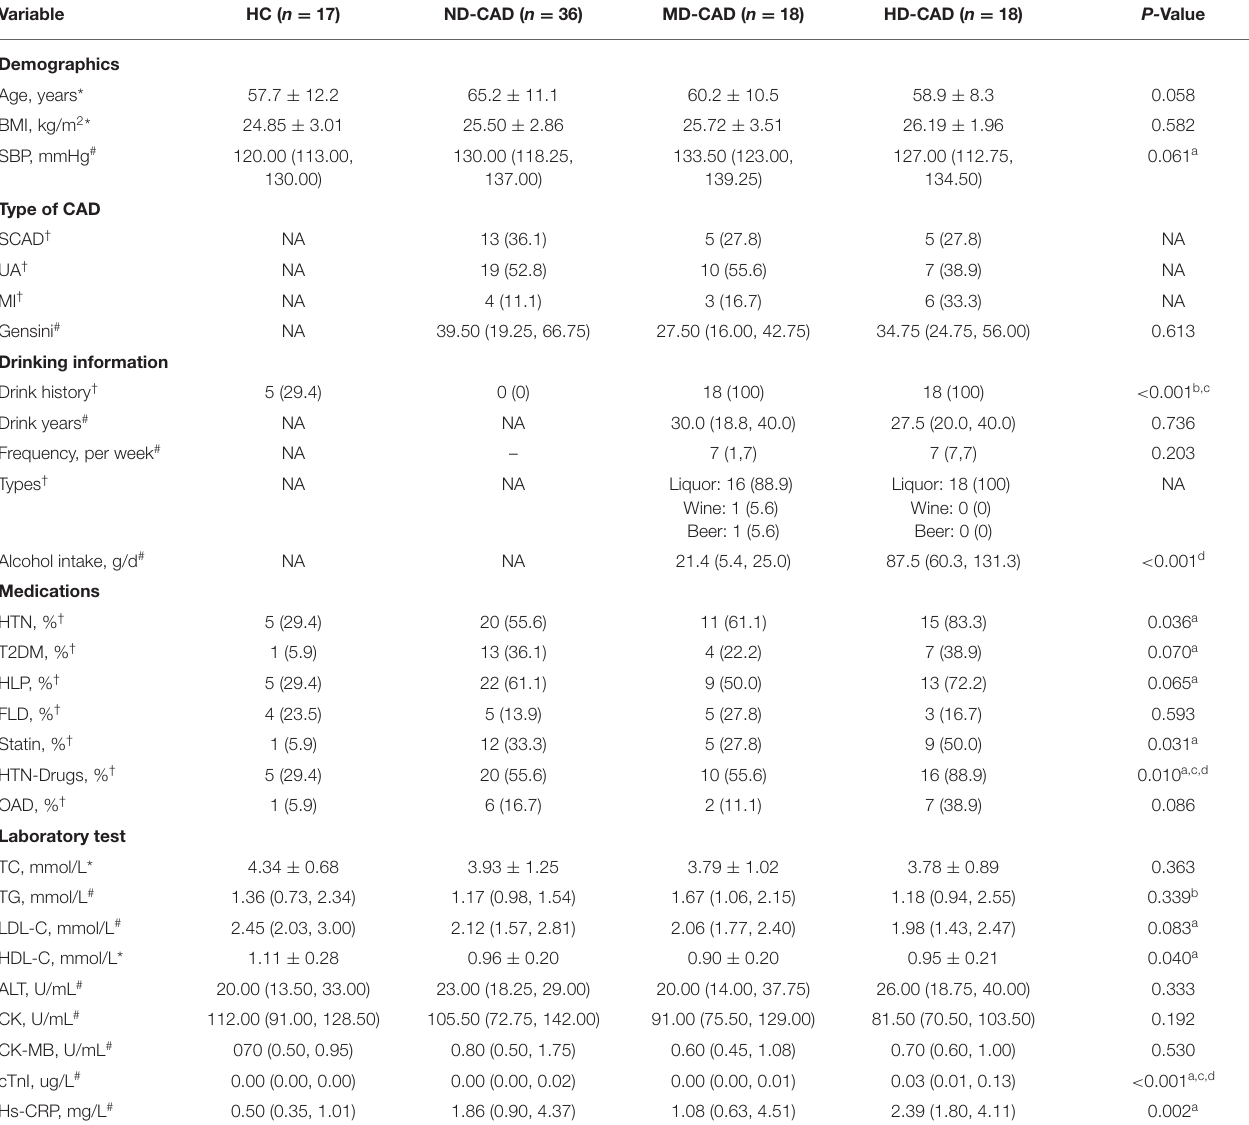
TABLE 1 | Characteristics of the study